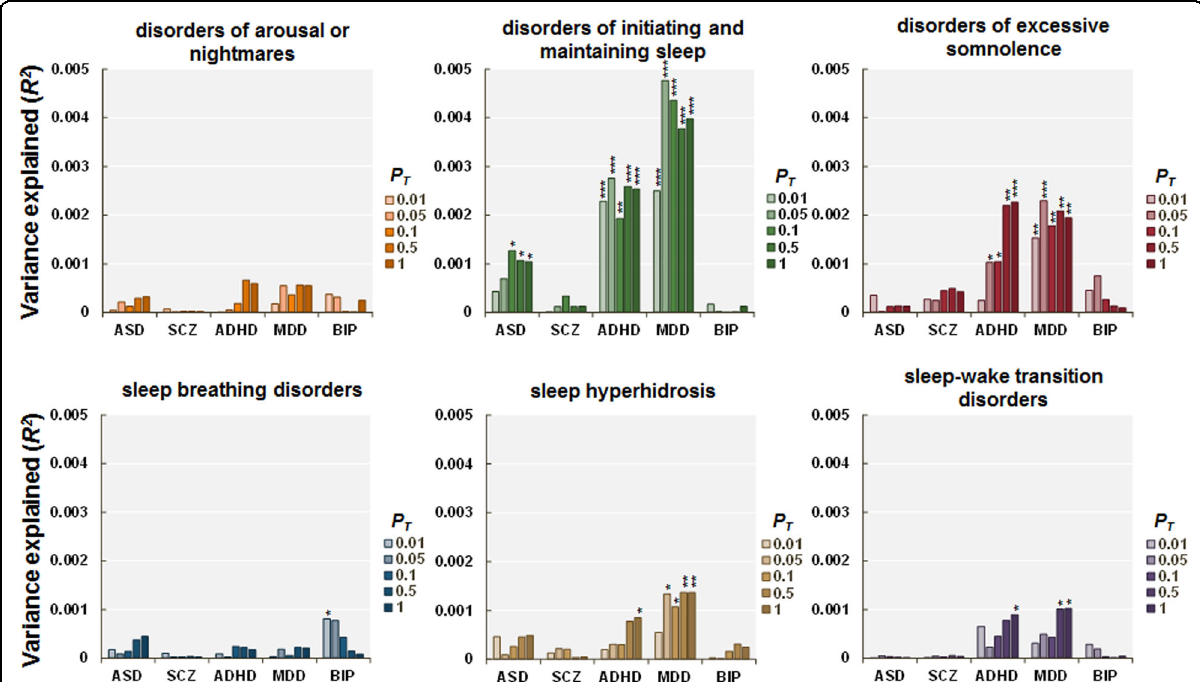
Fig. 3 Effects of PRSs for psychiatric and neurodevelopmental disorders. Effects of PRSs for psychiatric and neurodevelopmental disorders on the risk of six types of sleep disturbance in early adolescence in European children. *** p < 0.001, ** p < 0.01, * p <